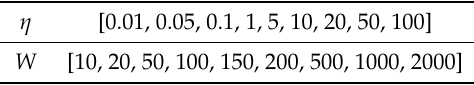
Table 2. The possible values of parameters.